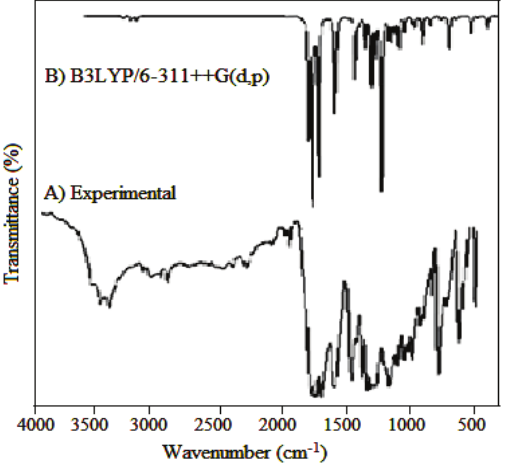
Figure 3 : Experimental and calculated FT-IR of N -acetylisatin.